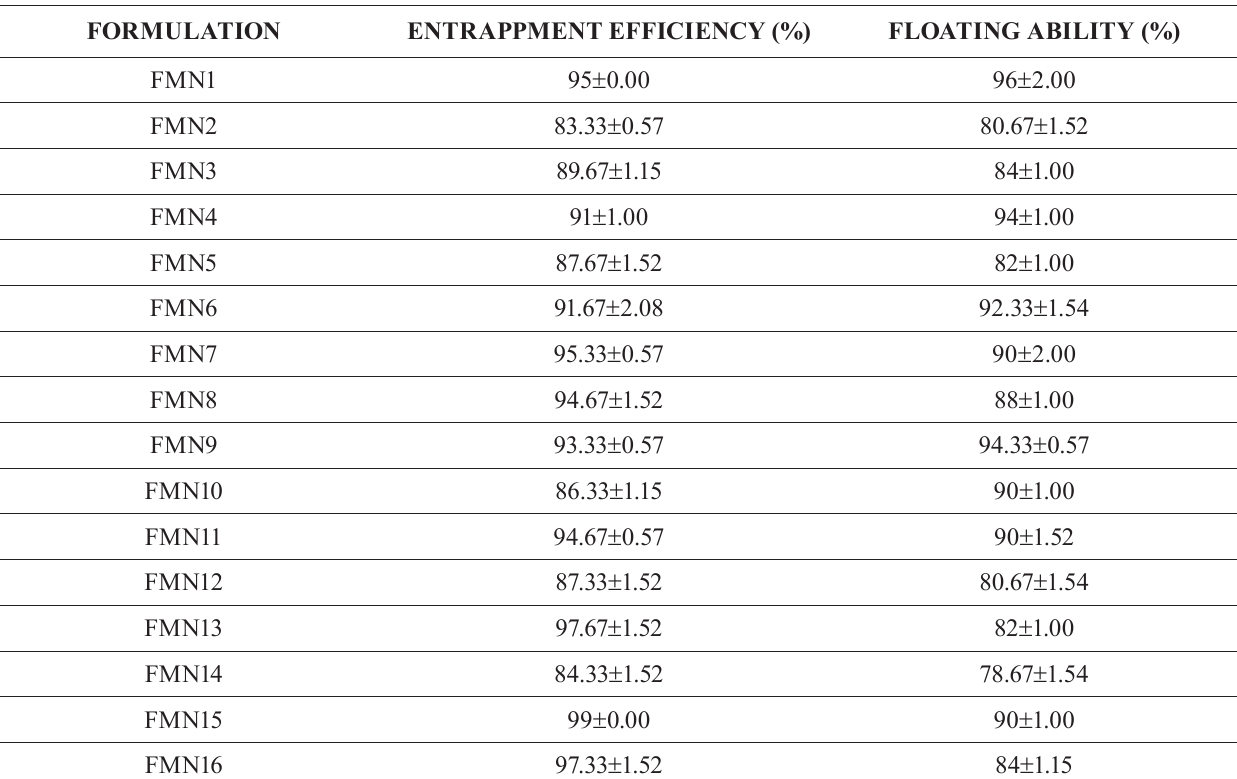
TABLE IV - Results of drug entrapment efficiency and floating ability